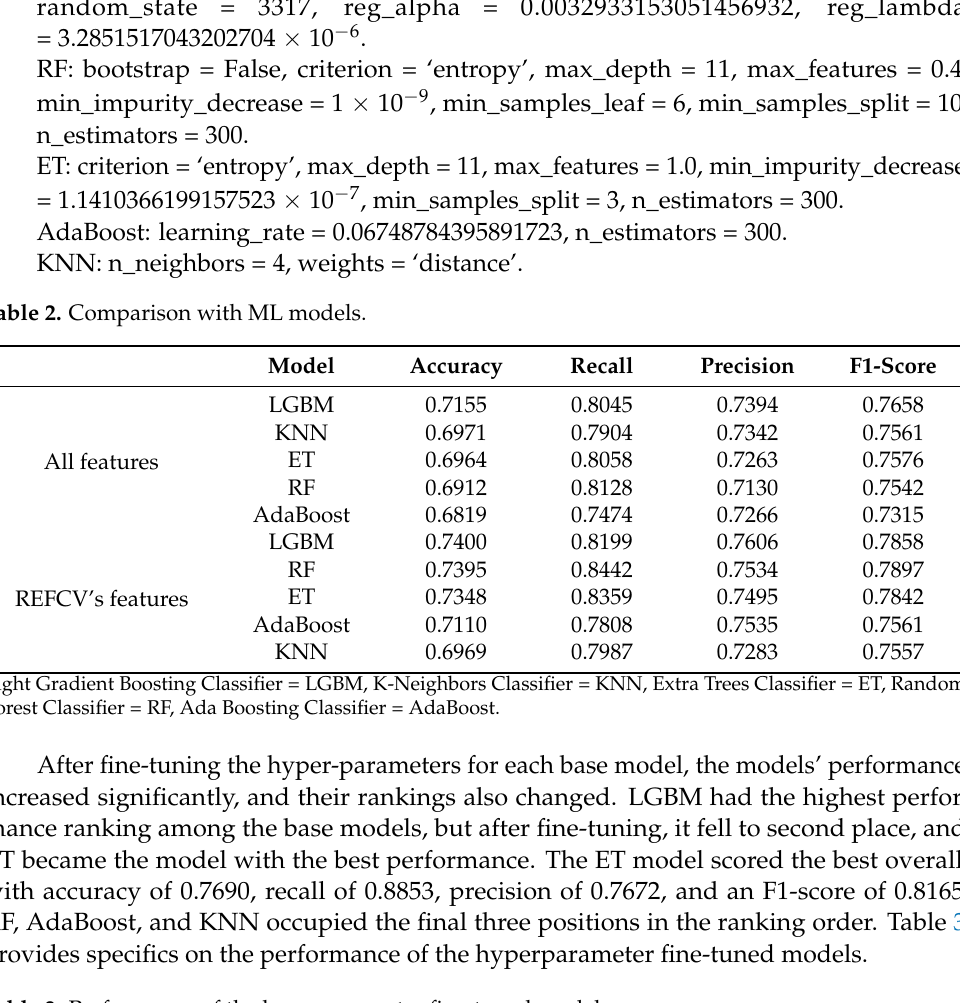
Table 2. Comparison with ML models.